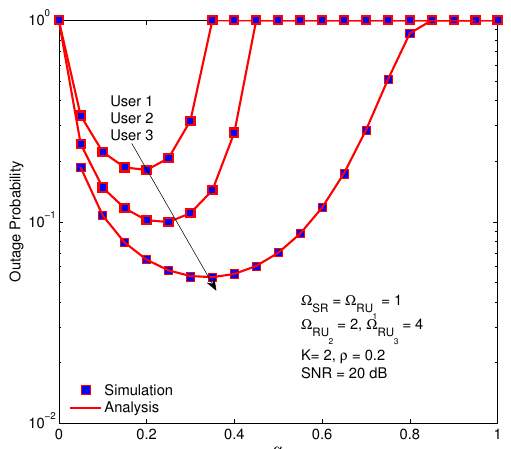
Figure 9. The optimal time fraction of EH corresponding to minimum OP of users with η = 0.85, a 1 = 0.6, a 2 = 0.3, a 3 =